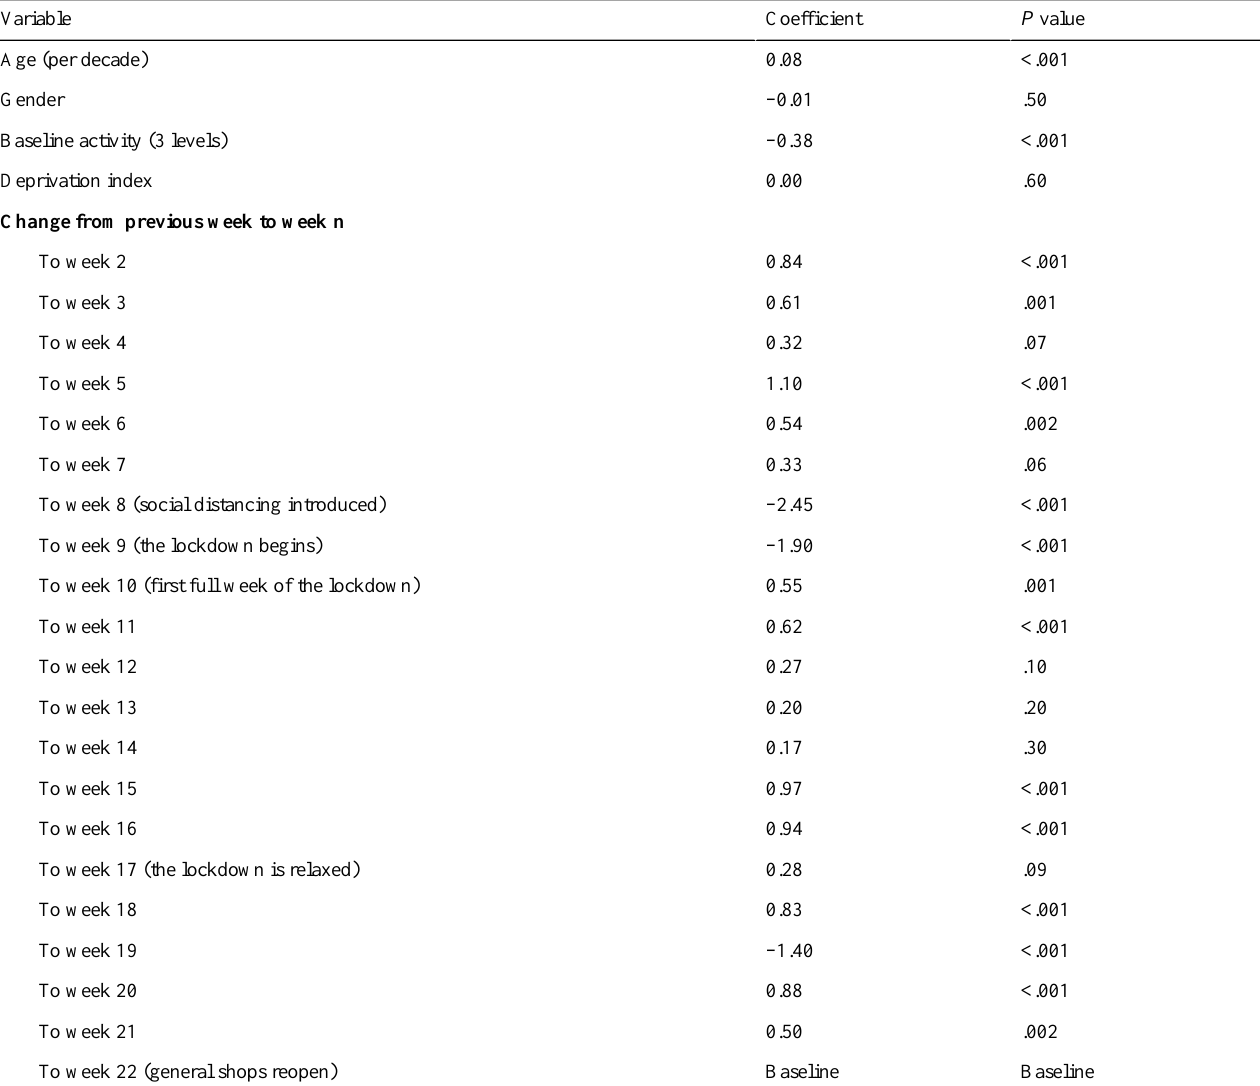
Table 5. Statistical analysis.